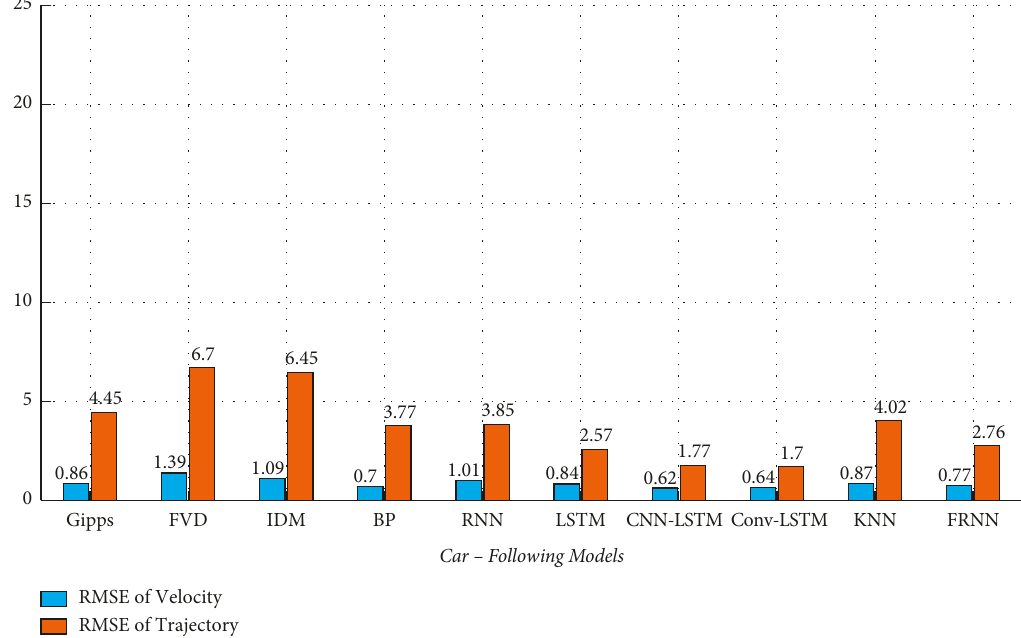
Figure 20: RMSE of conventional models and data-driven models in the discontinuous traffic flow (ANN